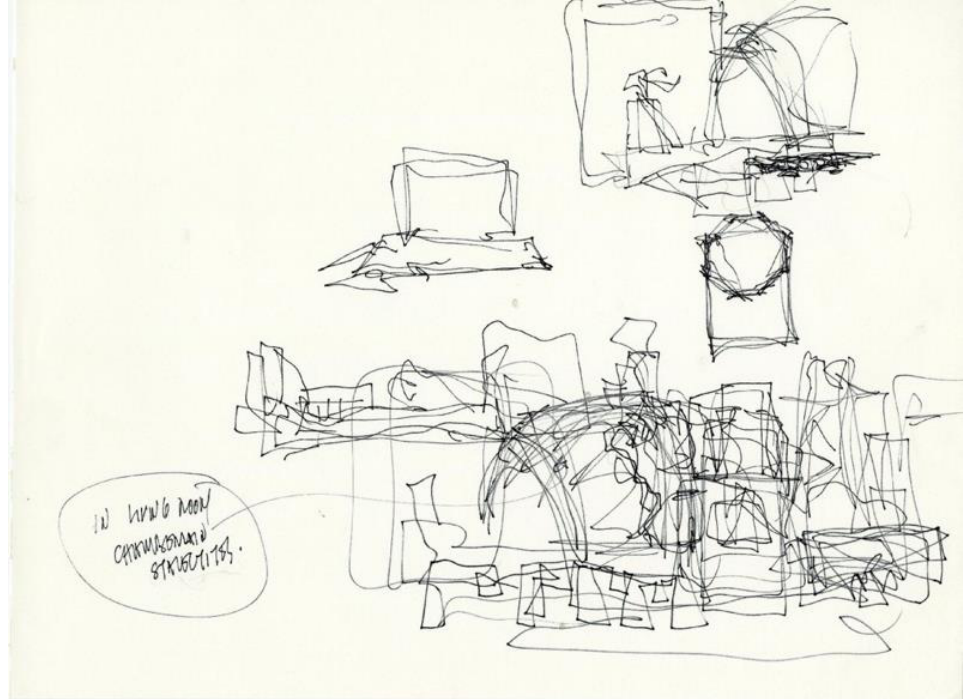
Figure 4. Frank Gehry, project sketch for Chiat Residence, Sagaponeck, New York, 1986 © Frank O. Gehry. Frank Gehry papers, Series I: Architectural Projects, Getty Research Institute, Los Angeles, CA. Digital image courtesy of the Getty Research Institute Digital